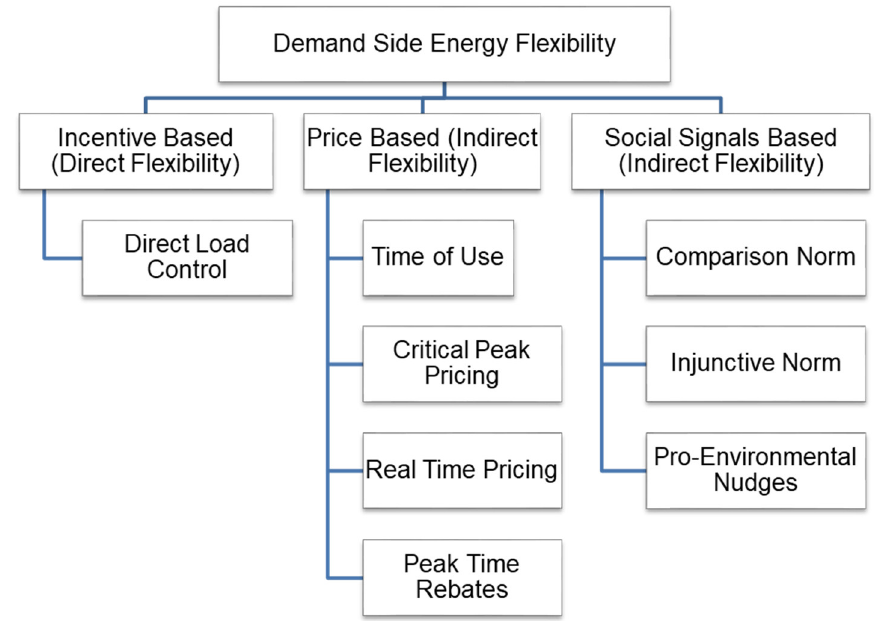
Figure 10. Types of Demand Side Energy Flexibility (DSEF).